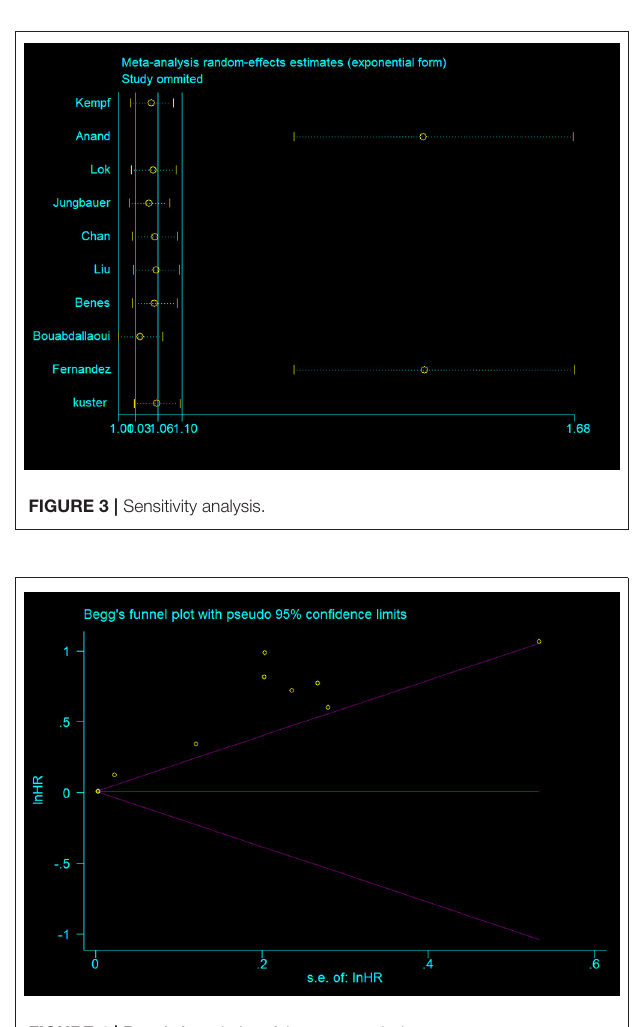
FIGURE 4 | Begg’s funnel plot of the meta-analysis.